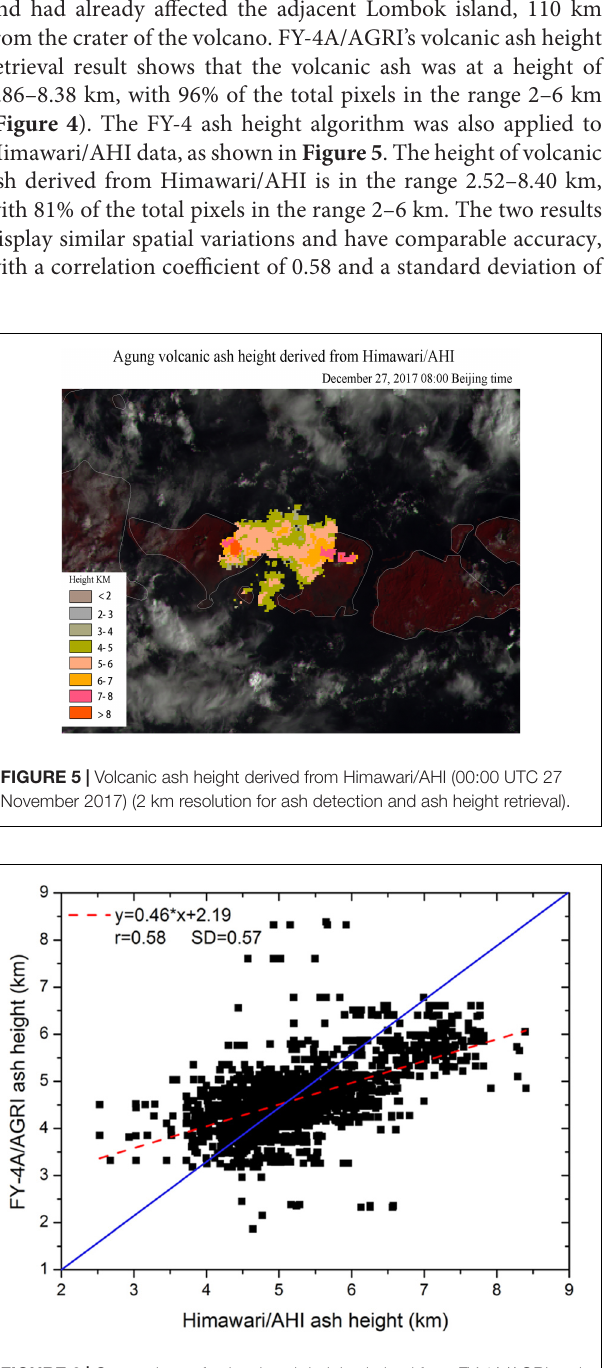
Frontiers in Earth Science |